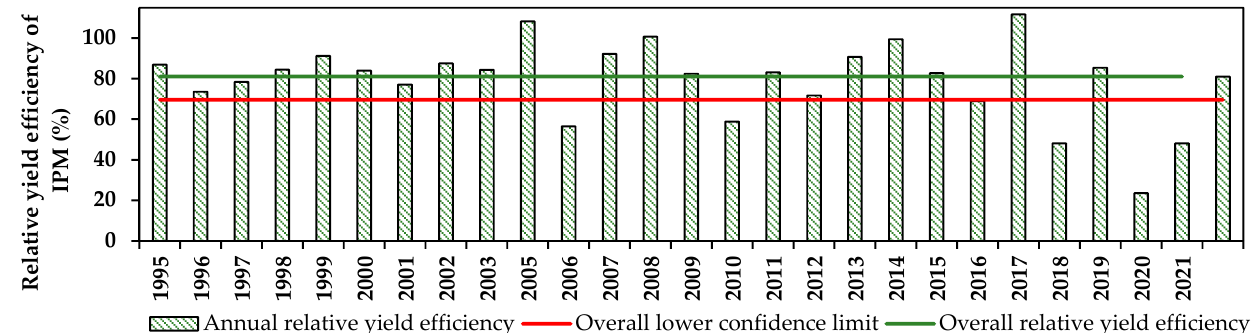
Figure 4. Overall relative yield efficiency (green line), overall lower confidence limit (red line; α = 0.05) and annual relative yield efficiency of the IPM treatment (green bars) in relation to the healthy-standard treatment adjusted by the untreated control from 1995 to 2021.